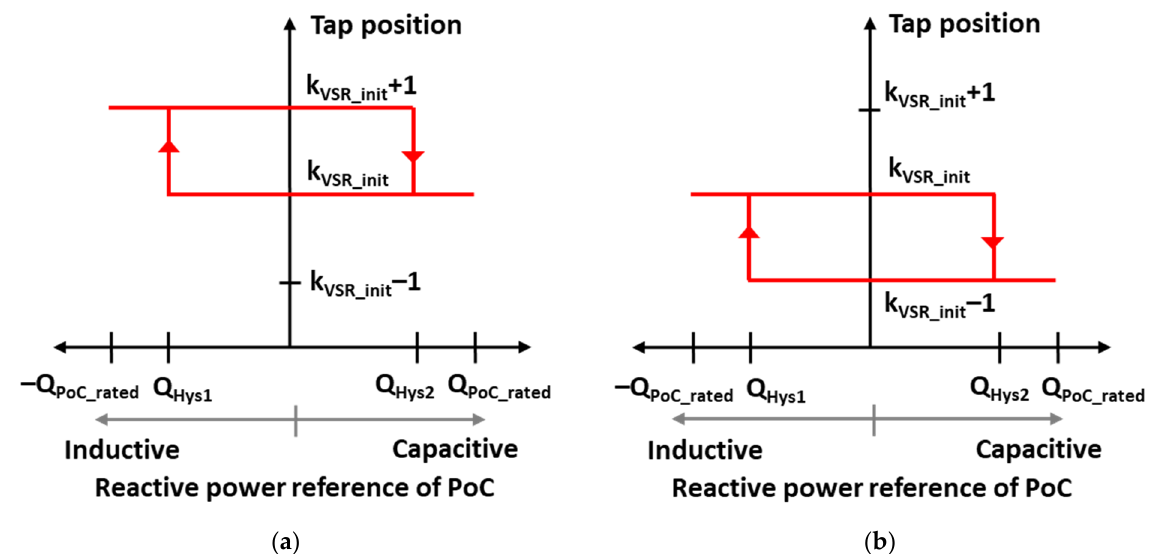
Figure 10. Hysteresis control concept diagram; ( a ) Hysteresis control setting when cable reactive power compensation error of the VSR is capacitive; ( b ) Hysteresis control setting when cable reactive power compensation error of the VSR is inductive.